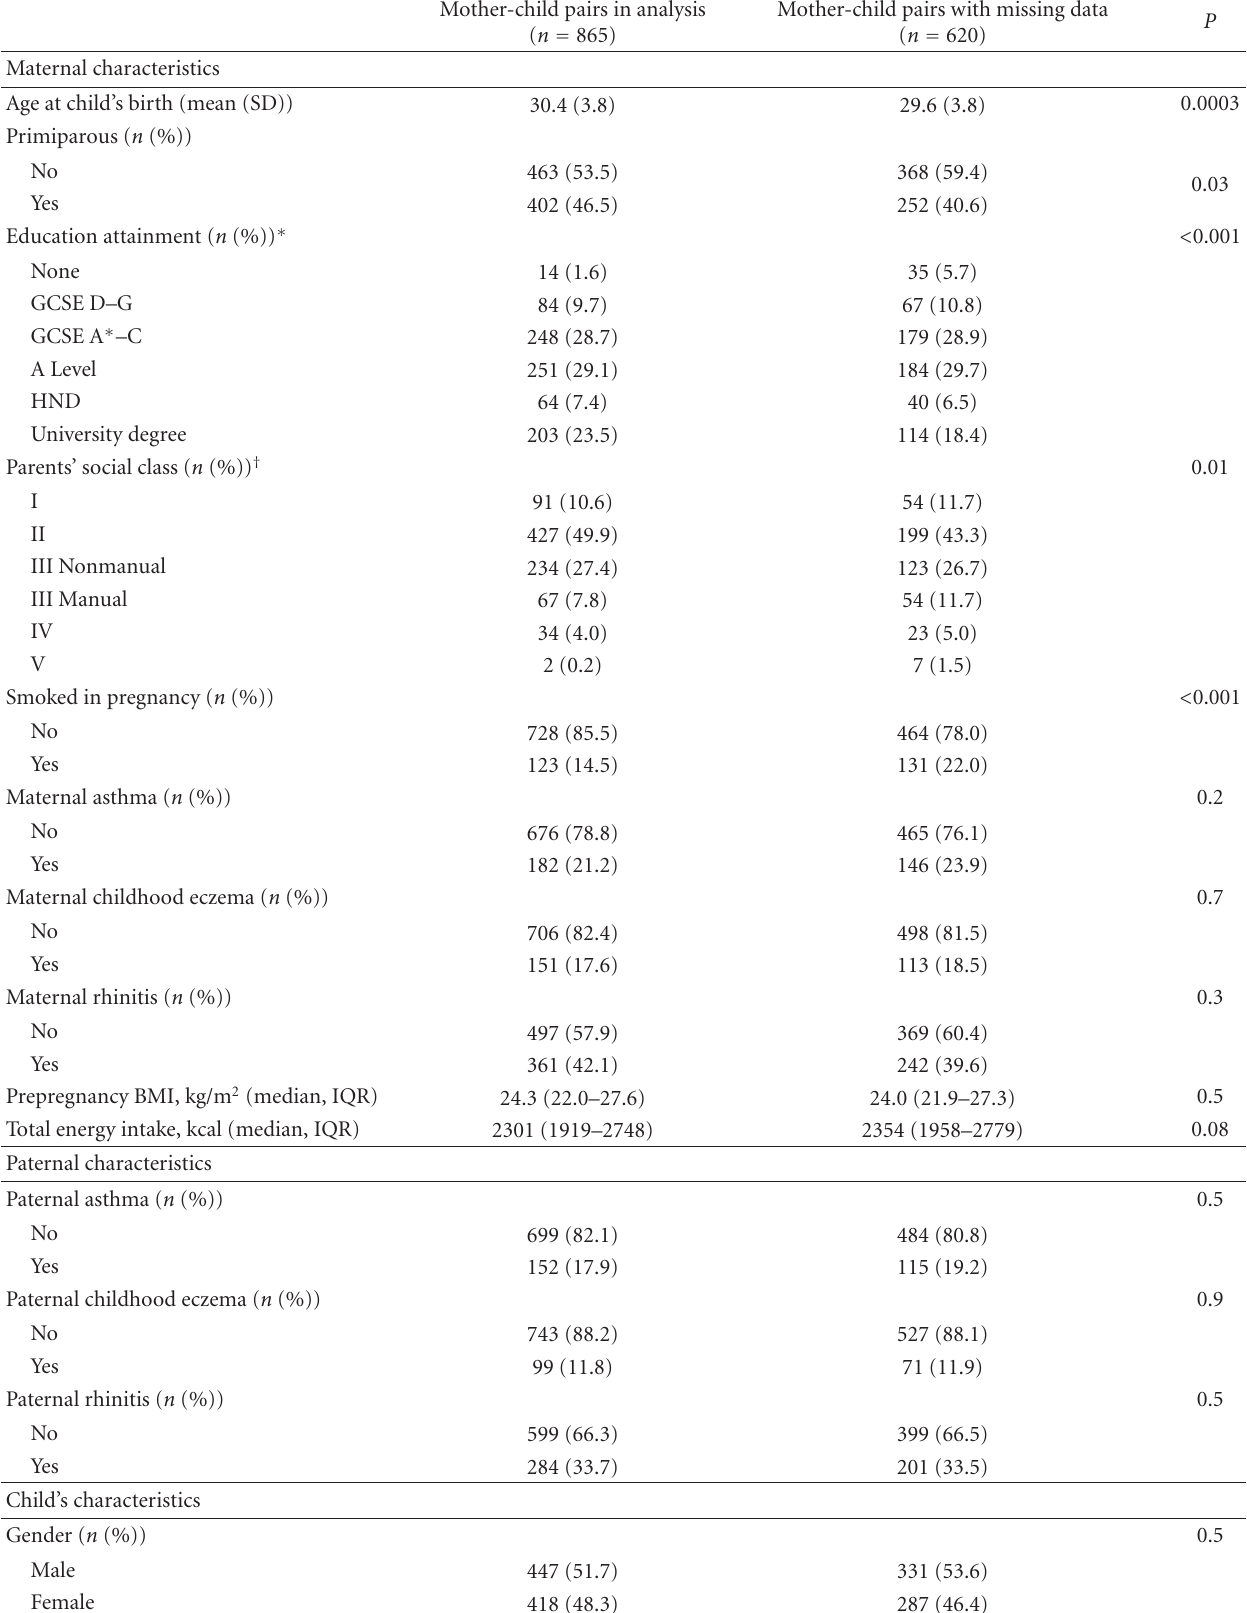
Table 1: Comparison of SWS mother-child pairs with complete data with those lacking either maternal fatty acid or 6-year follow-up data but born in the same time